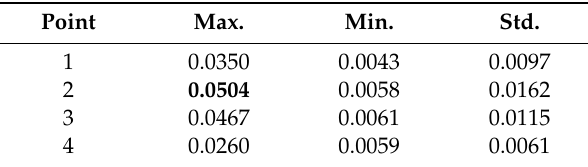
Table 2. Result of repeatability experiment (unit: